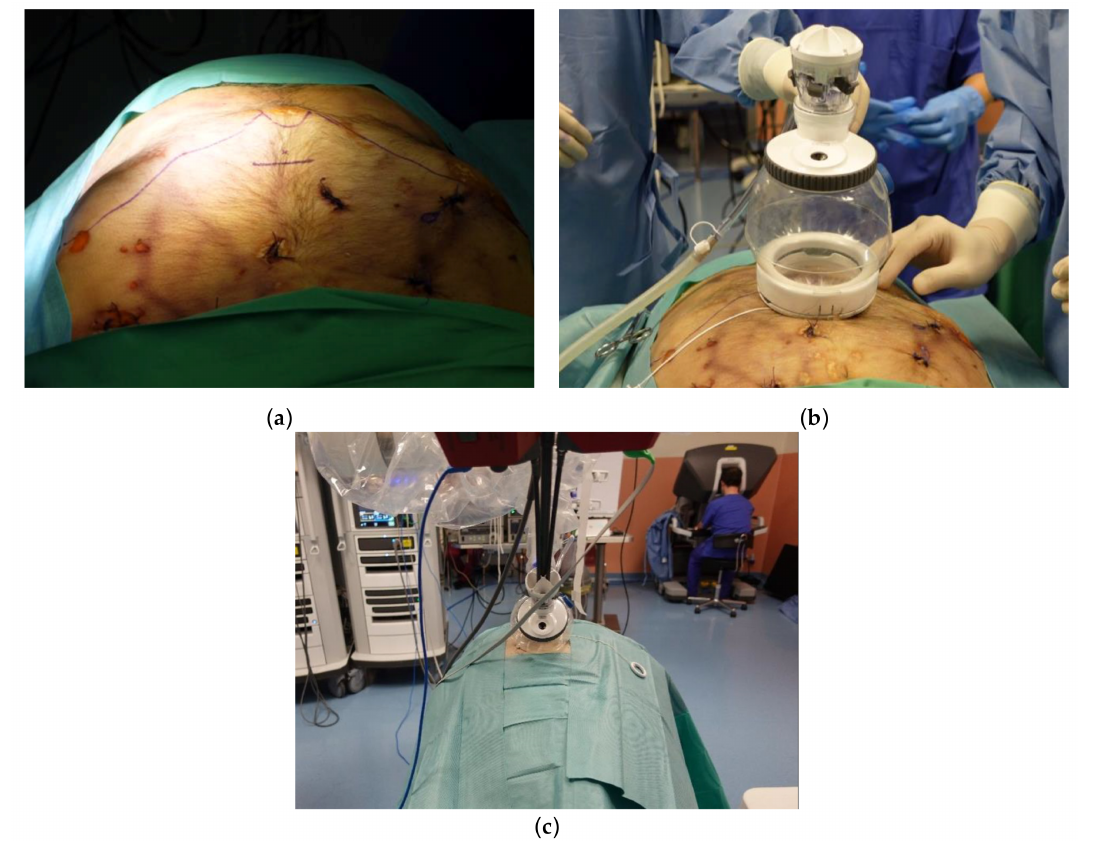
Figure 1. Subxiphoid thymectomy performed by means of the da Vinci ® SP system. ( a ) Incision design: a 3 cm incision was created approximately 2 cm caudal to the xiphoid process; ( b ) access port for the da Vinci ® SP platform; ( c ) whole view from the patient cart and the console.